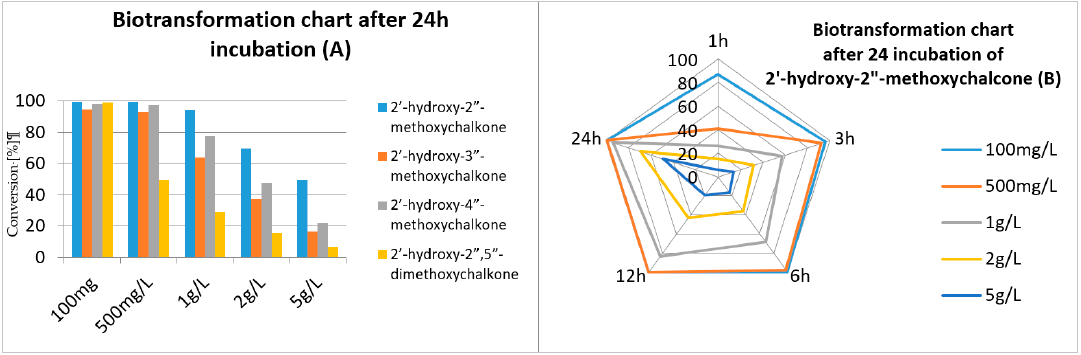
Figure 2. Comparison of conversions of increased substrate concentrations: after 24 h ( A ); conversion of 2 ′ -hydroxy-2 ″ -methoxychalcone ( 1 ) by Yarrowia lipolytica KCh 71 at increasing concentrations of substrate ( B ).